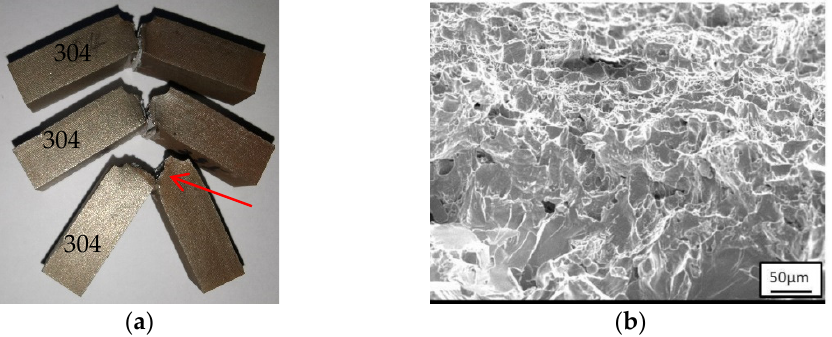
Figure 7. Charpy U-notched properties of the bonded joints ( a ) the photograph of the broken samples; ( b ) the SEM fractograph of the fracture.